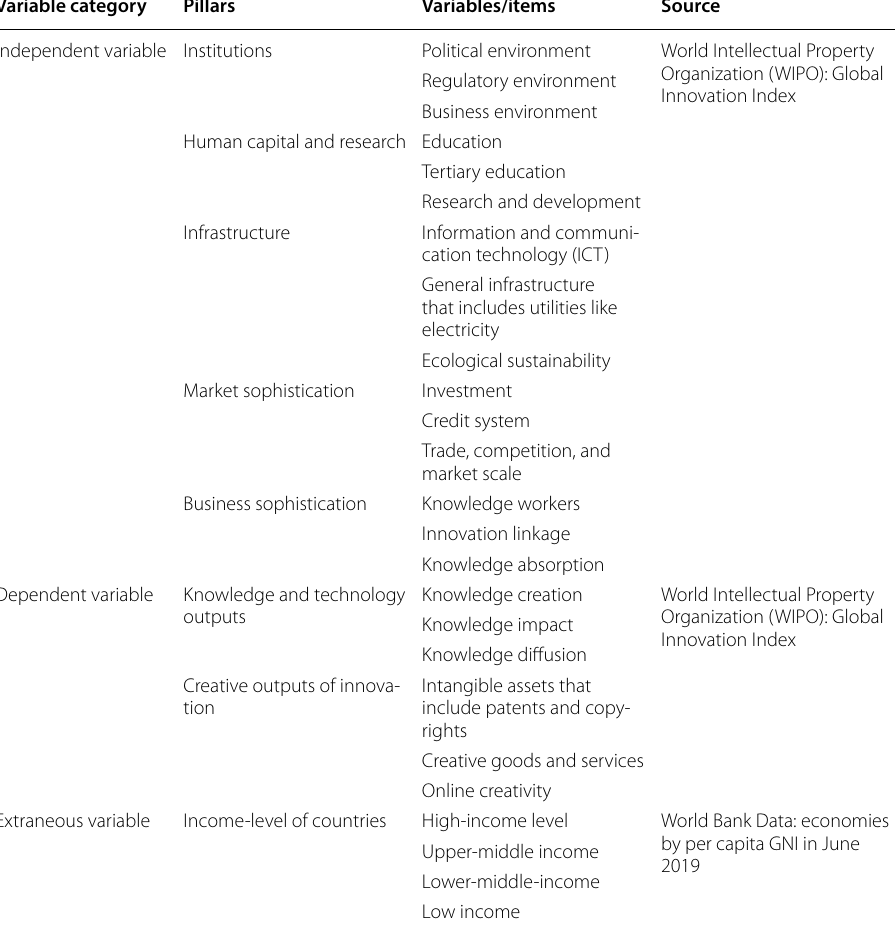
Table 2 Variable